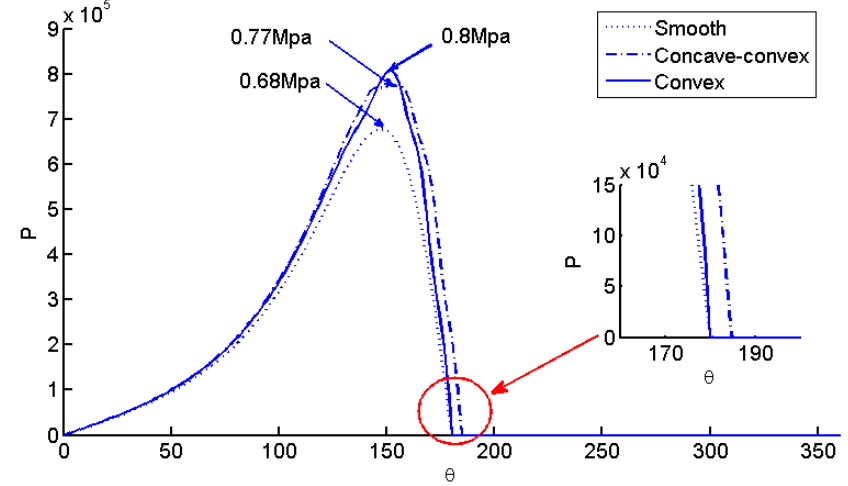
Figure 9. Circumferential oil film pressure distribution. Table 1. Load capacity and friction coefficient of bearings with the optimal parameters.